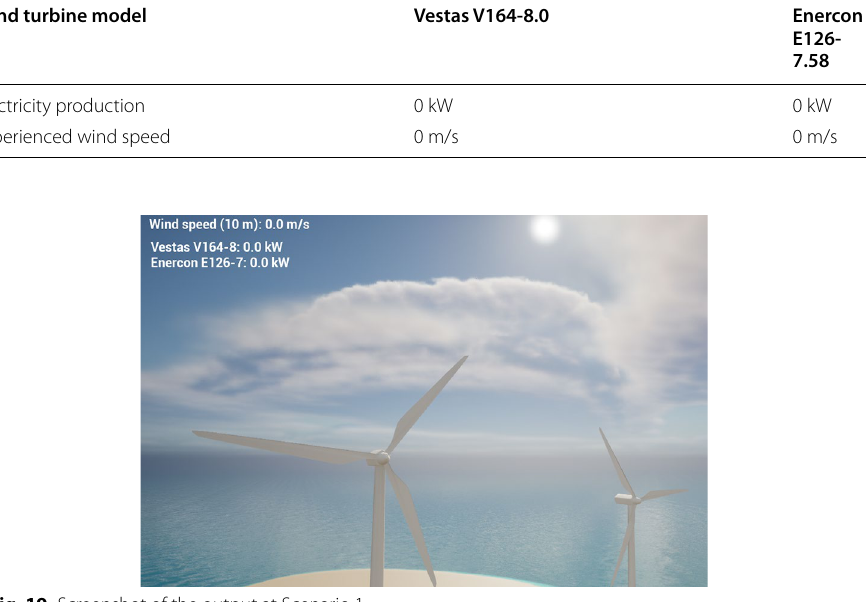
Fig. 19 Screenshot of the output at Scenario